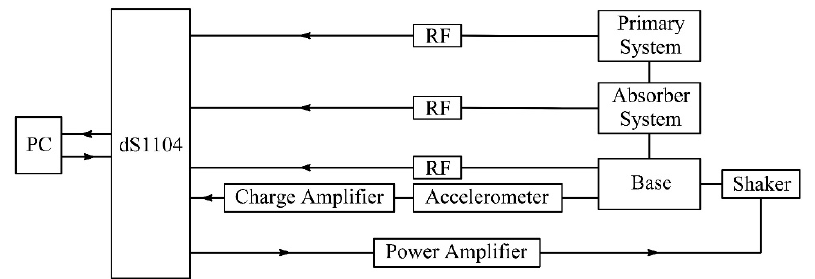
Figure 11. Flow chart of the experimental system.